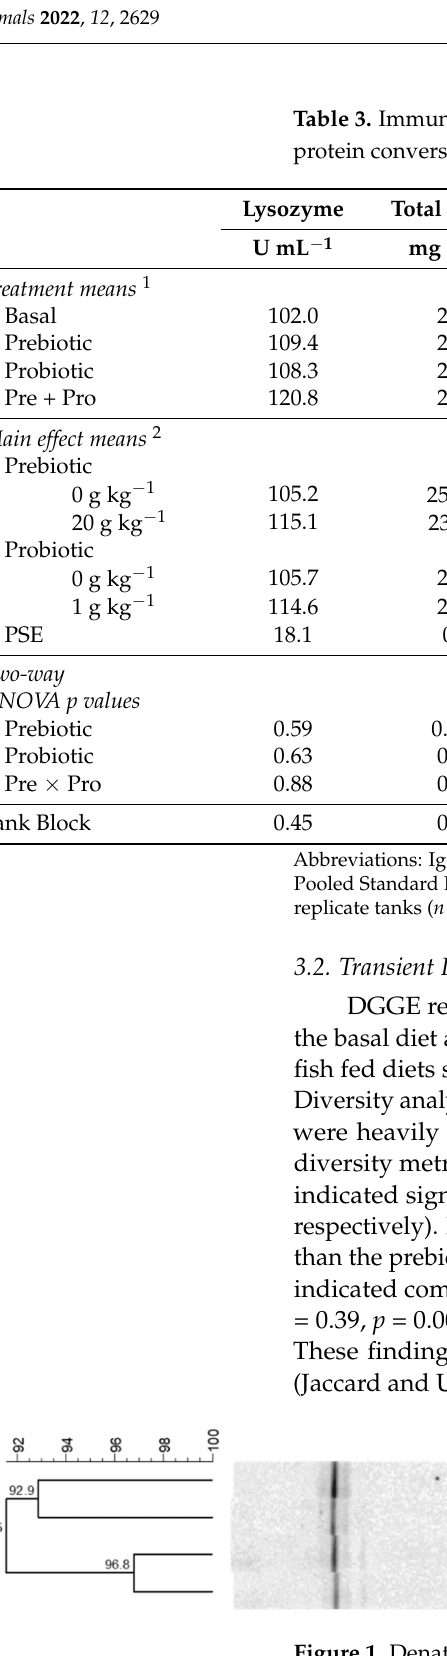
Figure 1. Denaturing gradient gel electrophoresis dendrogram of the red drum digesta microbiota. Percentage similarity coefficient (%SC, bar) ≤ 79% = not similar populations; %SC = 80–84% some- what similar; %SC 85–89% similar; %SC = 90–94% very similar; and %SC ≥ 95% likely the same or